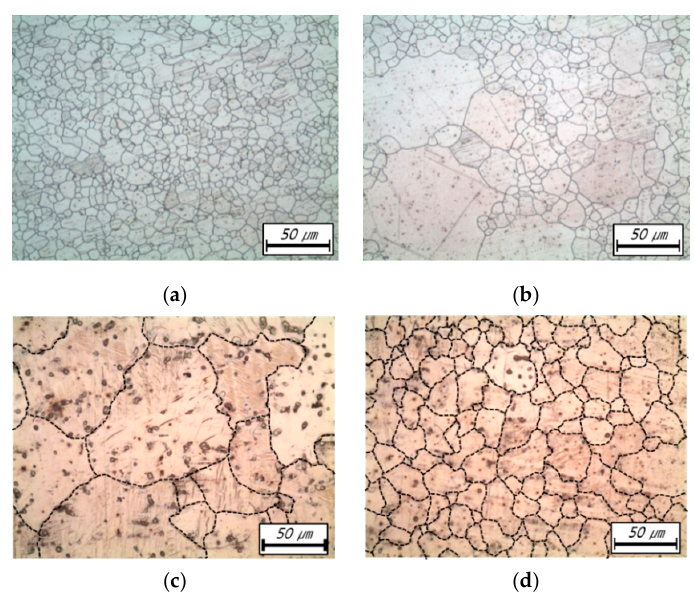
Figure 8. Microstructures of ( a ) base metal (BM); ( b ) heat ‐ affected zone (HAZ); and weld metal (WM) ( c ) AZ31 ‐ A; ( d ) AZ31 ‐ B.